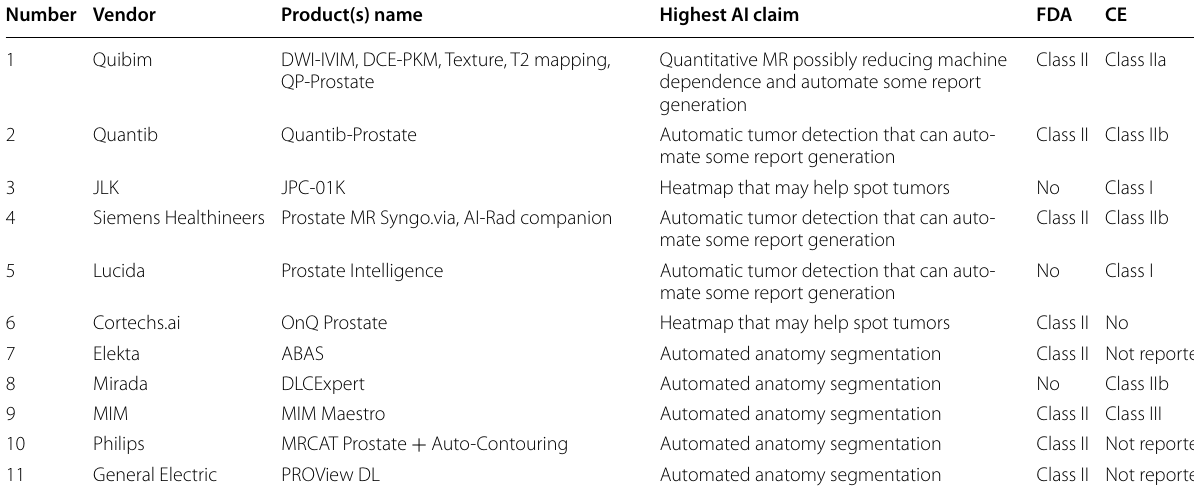
AI Artificial intelligence, CE European conformity, FDA Food and Drug Administration. For more information, check [59] for detailed descriptions of features and links to vendor websites and related